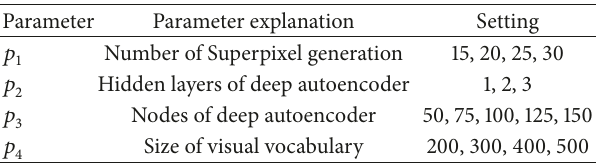
Table 4: Performance with data